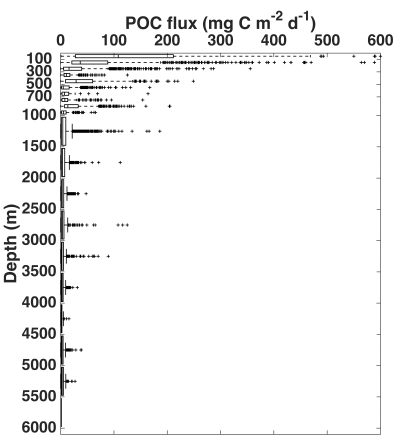
Figure 4. Global POC flux variability with depth. POC flux ob- servations are binned every 100m in the upper 1000m and every 500m throughout the rest of the water column. Box edges enclose the 25th and 75th percentiles of data within each bin with the me- dian shown as a vertical line. Error bars extend to the 5th and 95th percentiles and remaining outliers are indicated with + . There are eight data points not represented on the plot, as they were signifi- cantly higher than the majority of the data set. These values were observed < 225m and are 620, 660, 677, 694, 830, 852, 950, and 1238mgCm − 2 d − 1